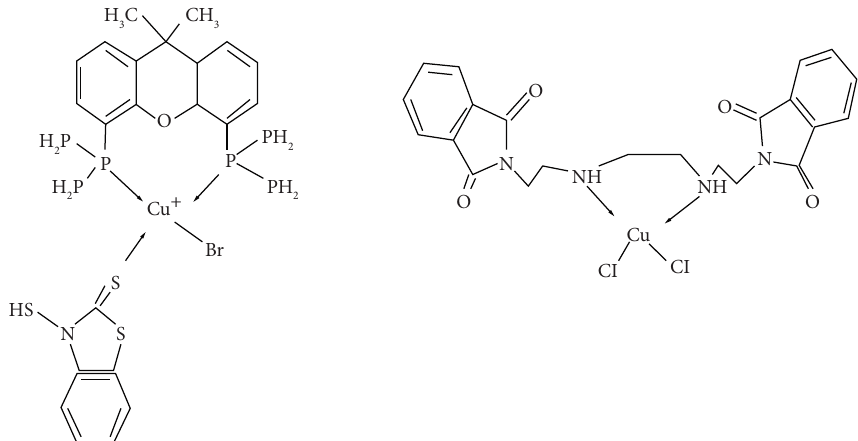
Figure 3: Structure of antimicrobial copper complexes (compound 4 and compound 5) [37, 38].